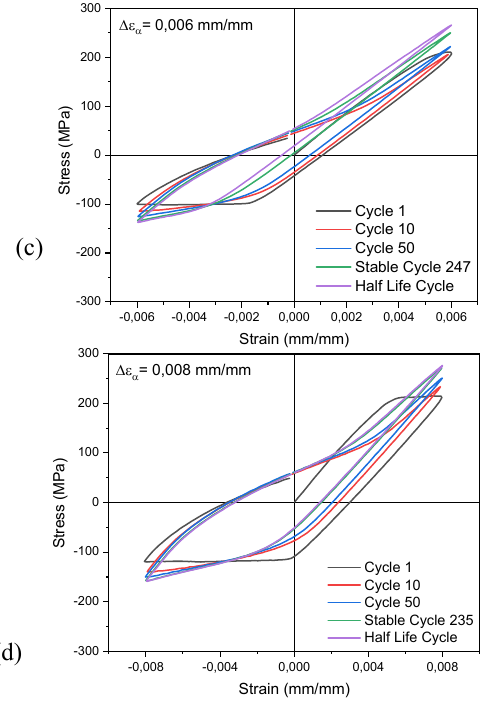
Figure 7. Hysteresis curve of the extruded Mg AZ31B at different fatigue cycles (in mm/mm) of (a) 0.004, (b) 0.005, (c) 0.006, (d) 0.008, and (e) 0.01 The evolution of the hysteresis curve in Figure